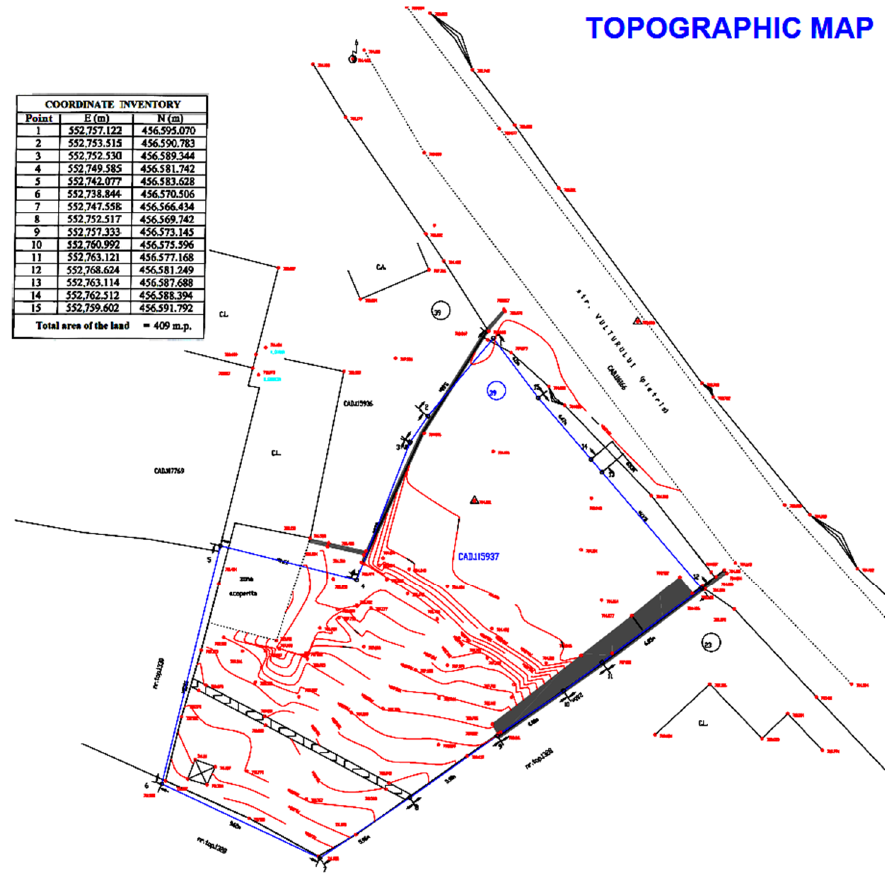
Figure 10. Topographic map. Table 1. The x and y coordinates of the Q